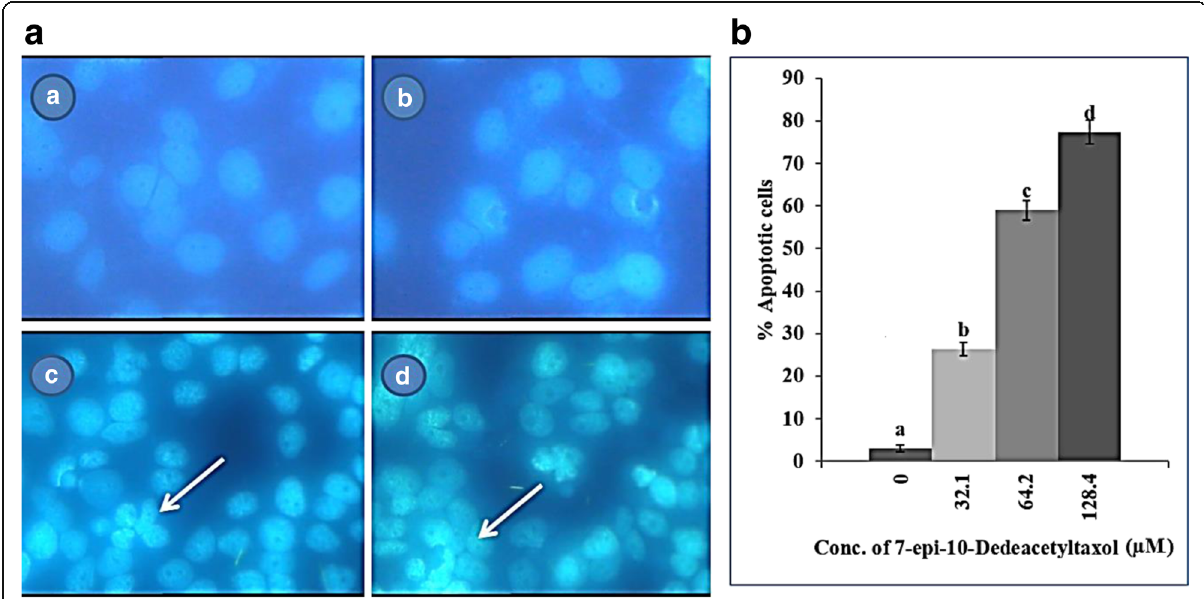
Fig. 8 Effect of fungal EDT on nuclear condensation in HepG2 cells. Fluorescence microphotographs of untreated and treated cells were obtained after DAPI staining. a A Fluorescence microphotographs of untreated HepG2 cells, (a B-D ) HepG2 cells treated with 32.1 μ M, 64.2 μ M and 128.4 μ M, respectively of fungal EDT. Arrows indicating condensed nuclear foci. b The percentage of apoptosis in HepG2 cells treated with indicated concentrations of